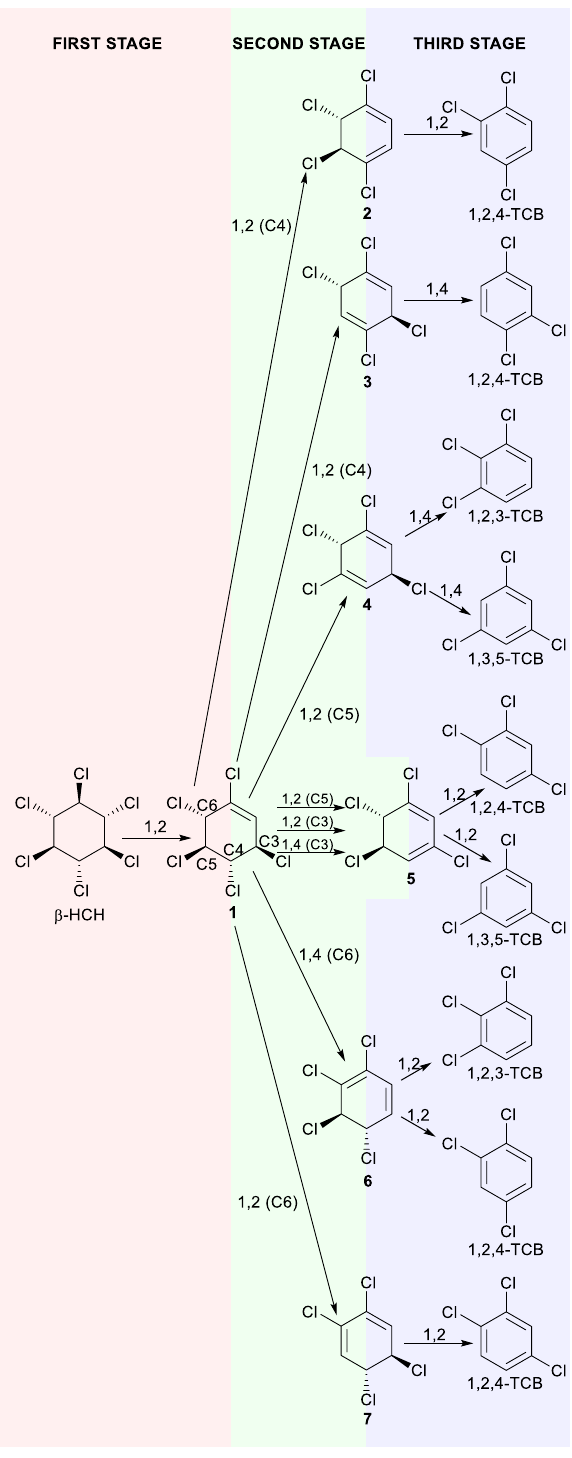
Figure 2. β-HCH dehydrochlorination reaction pathways indicating the regiochemistry (1,2 vs. 1,4) and the carbon undergoing deprotonation (in parentheses, if necessary) of every elimination